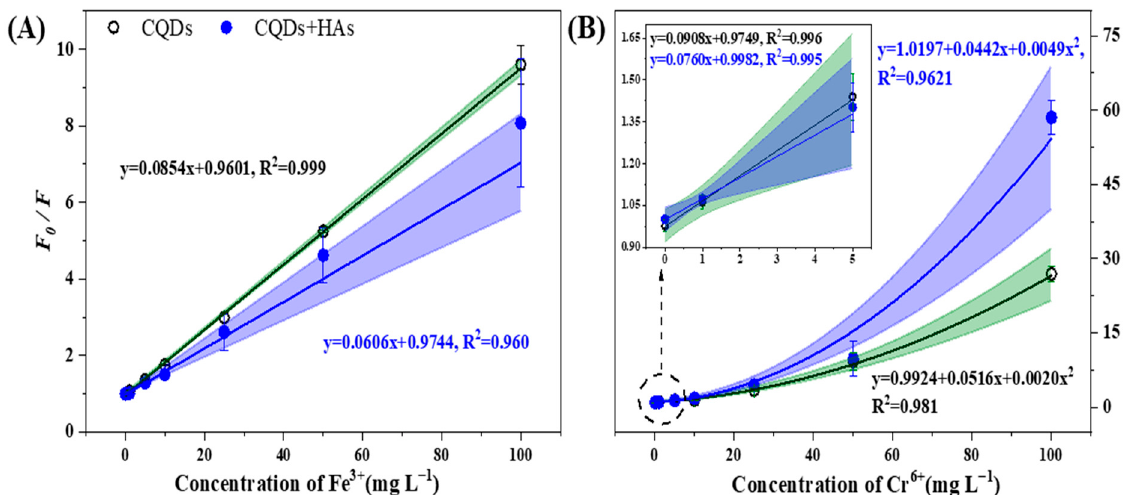
Figure 3. Fluorescence quenching of the cyanobacteria carbon quantum dots (CQDs) by ( A ) Fe 3+ and ( B ) Cr 6+ as affected by humic acids (HAs). F 0 / F indicates the initial fluorescence intensity of CQDs divided by the fluorescence intensity of CQDs after interaction with Fe 3+ or Cr 6+ ions. The shaded area represents the confidence bands of the data, and the error bars represent standard deviations (n = 3).